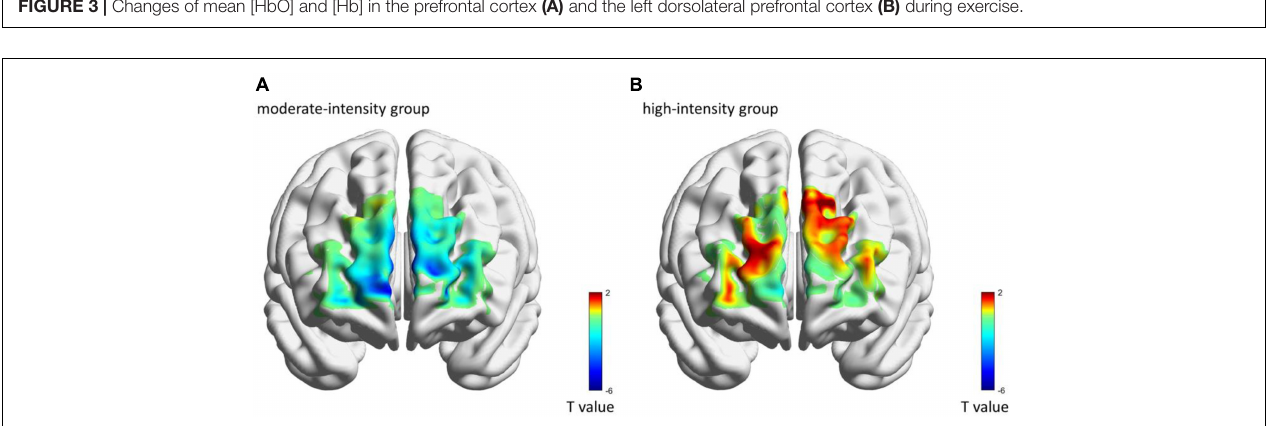
FIGURE 3 | Changes of mean [HbO] and [Hb] in the prefrontal cortex (A) and the left dorsolateral prefrontal cortex (B) during exercise.